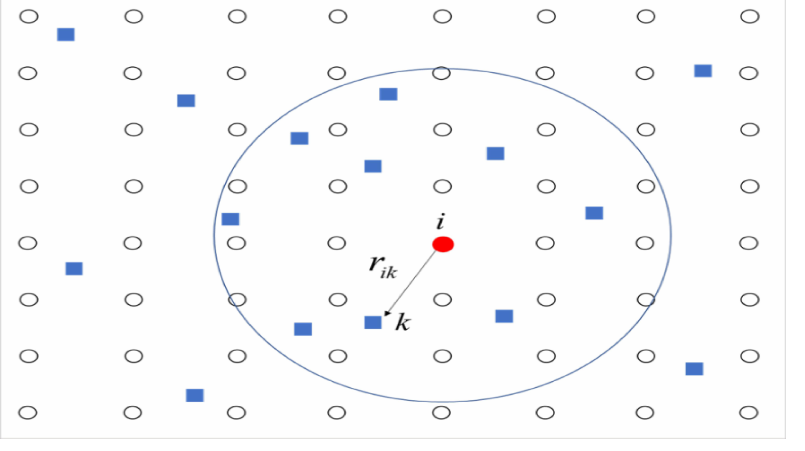
Figure 2. Model data coordinates (circle) and observation data (square)